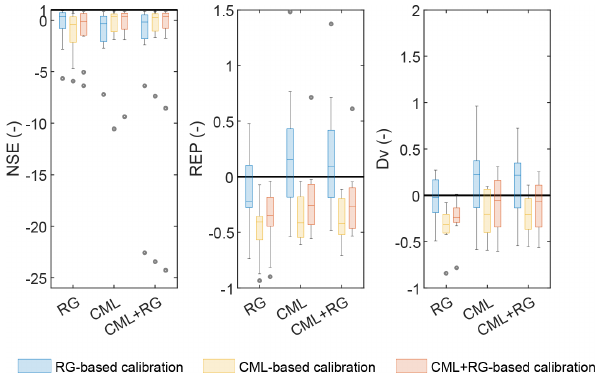
Figure 13. Box plots of the performance indices for the 12 flood events obtained with three different calibration sets (drawn in as many colours) and with three different input types (on the x axis). The box plots display the median, the 0.25 (lower) and 0.75 (upper) quantiles, outliers (computed using the interquartile range), and the minimum and maximum values excluding any